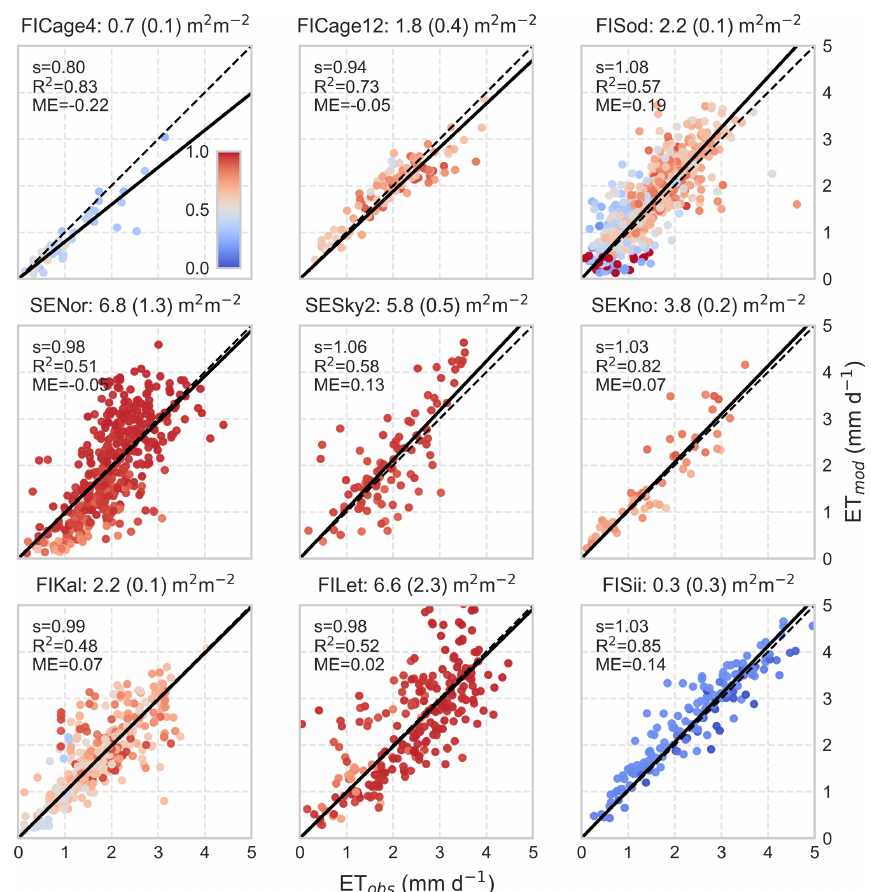
Figure 5. Scatter plots between modeled and observed daily stand-level ET during the growing season at the eddy-covariance flux sites in Finland and Sweden (Table 2). The title of each panel shows LAI (maximum deciduous LAI in parenthesis). The slope s and R 2 of linear regression forced through the origin and mean error ME are given and dashed line is the 1 : 1 line. Only dry canopy conditions, i.e. no rain during the day or previous day is included. At the pristine fen peatland site FISii, E f was assumed to be non-limited by organic layer moisture. Color coding is according to transpiration to the ET ratio T r /(T r + E f )